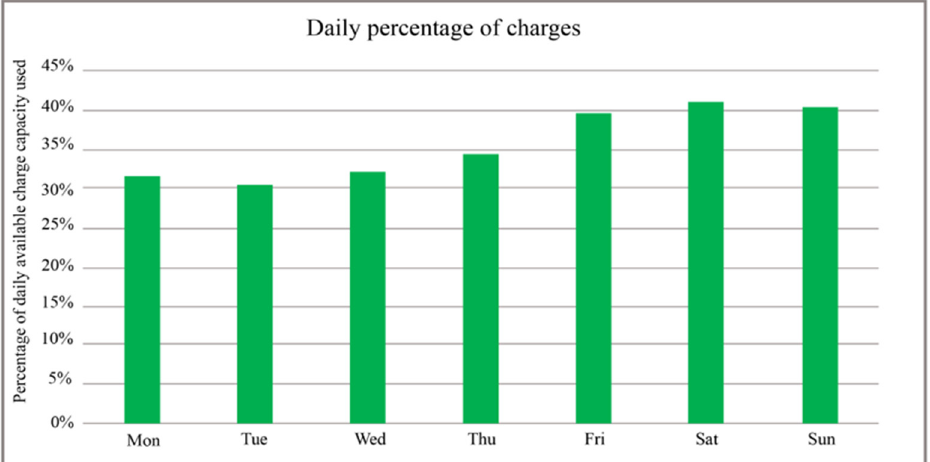
Figure 8. Daily percentage of grid supply usage versus time [8].